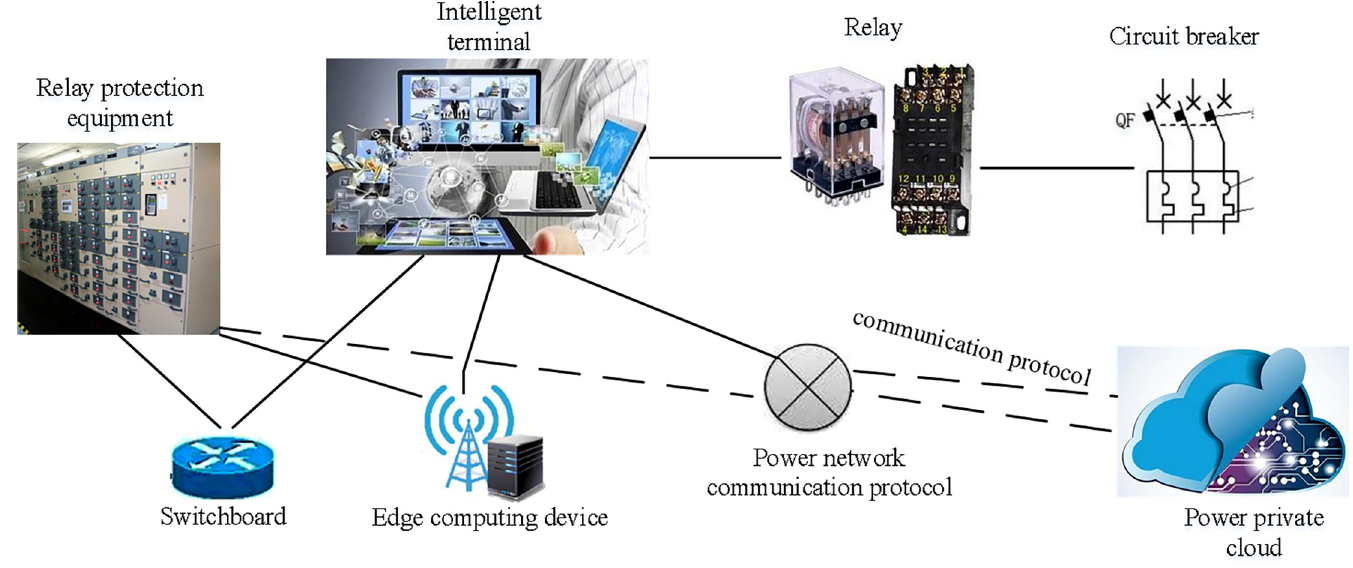
Fig 5. Relay protection system in edge